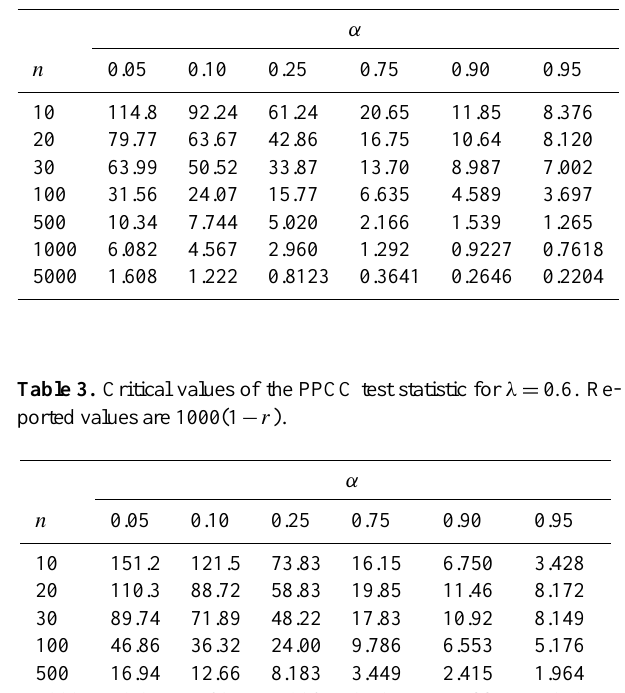
Table 2. Critical values of the PPCC test statistic for λ = 0 . 3. Re- ported values are 1000(1 − r ).